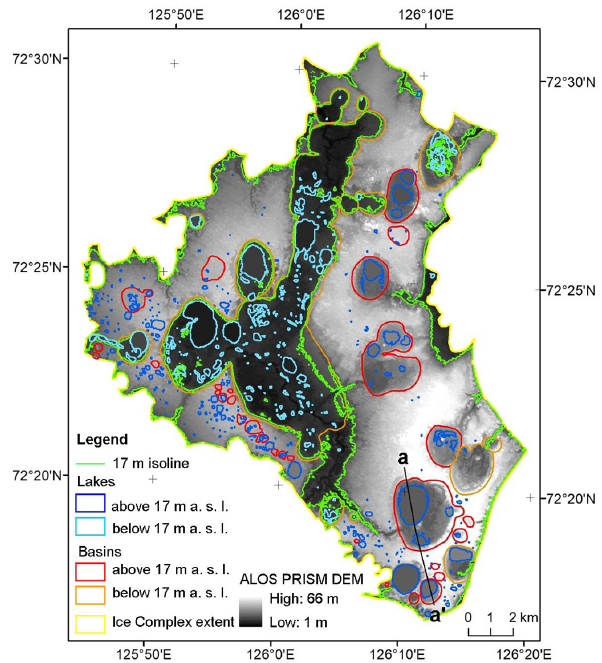
Fig. 12. Yedoma uplands of Kurungnakh Island unaffected by thermokarst or thermal erosion with slopes < 2 ◦ . This area (33.7% of Kurungnakh Island) is vulnerable to future